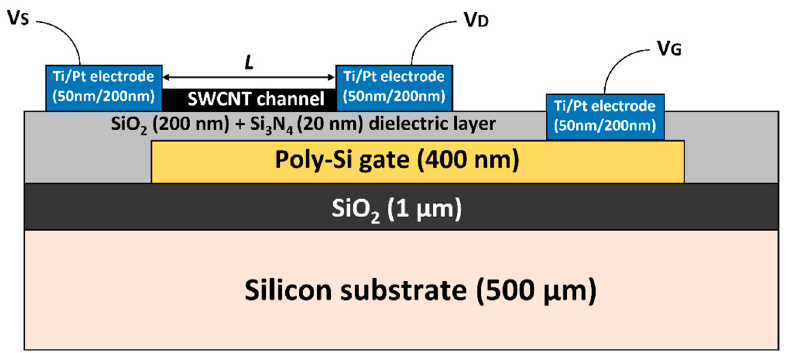
Figure 1. Schematic representation of the bo tt om-gated CNTFETdevices. Vs: Source voltage, V D : Drain voltage, V G : Gate voltage, L: Channel length varying from 5 µm to 120 µm.